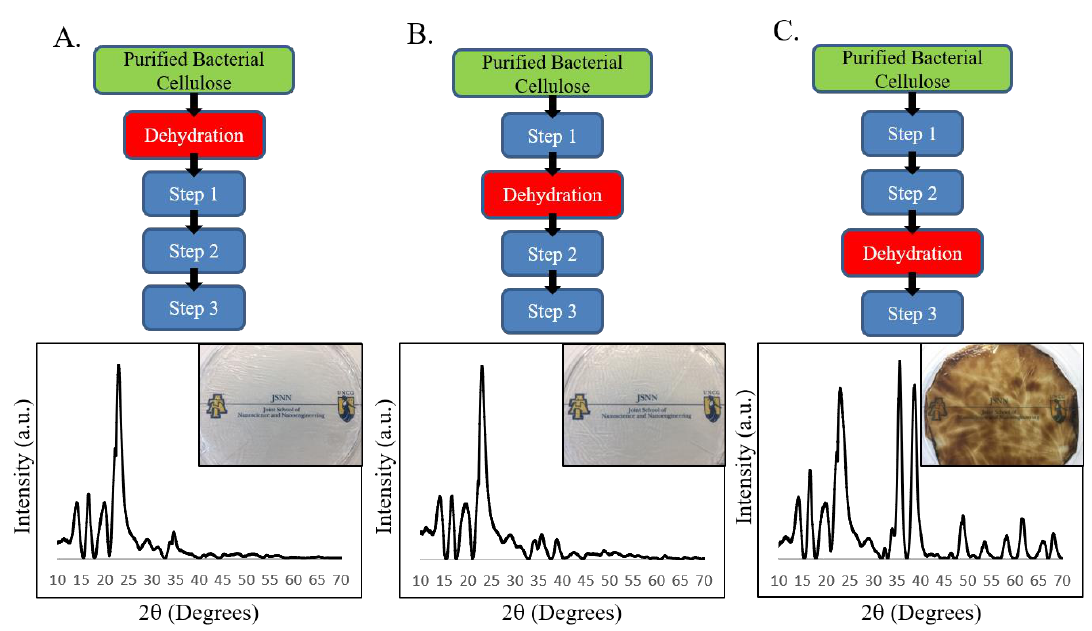
Figure 3. Hydration state of BC is essential for formation of CuO nanomaterial: Step 1, incubation of purified BC pellicle in 50 mM CuSO 4 ; Step 2, formation of BC–Cu(OH) 2 composite material via incubation of the rinsed copper treated BC pellicle in 0.1 M NaOH; Step 3, heating BC–Cu(OH) 2 composite at 60 ◦ C for 30 min. ( A ) Dehydration of BC pellicle prior to Step 1 results in no formation of CuO material as evidenced by the XRD spectrum lacking the CuO signature and a pellicle with no color change (inset); ( B ) Dehydration of BC pellicle after copper treatment (Step 1) but before the formation of Cu(OH) 2 (Step 2) also results in the failure to form CuO as evidenced by XRD and a lack of color change in the pellicle (inset); ( C ) Dehydration of the BC pellicle after Cu(OH) 2 formation (Step 2) and prior to the heating (Step 3) results in the deposition of CuO material in the BC matrix, as evidenced by XRD and a brown colorimetric change to the pellicle (inset).